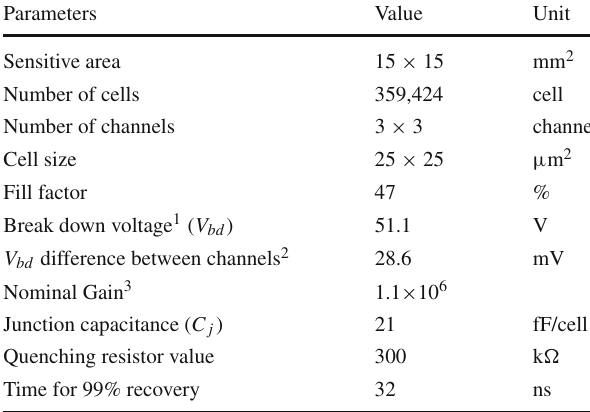
Table 1 Specifications of the WFCTA SiPM (Hamamatsu S14466)